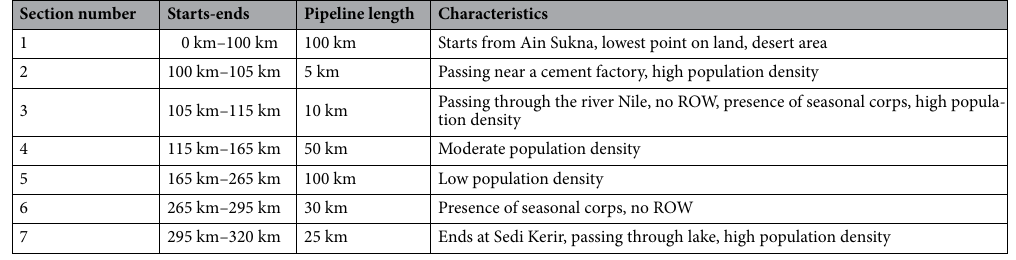
Table 5. Pipeline sections 58